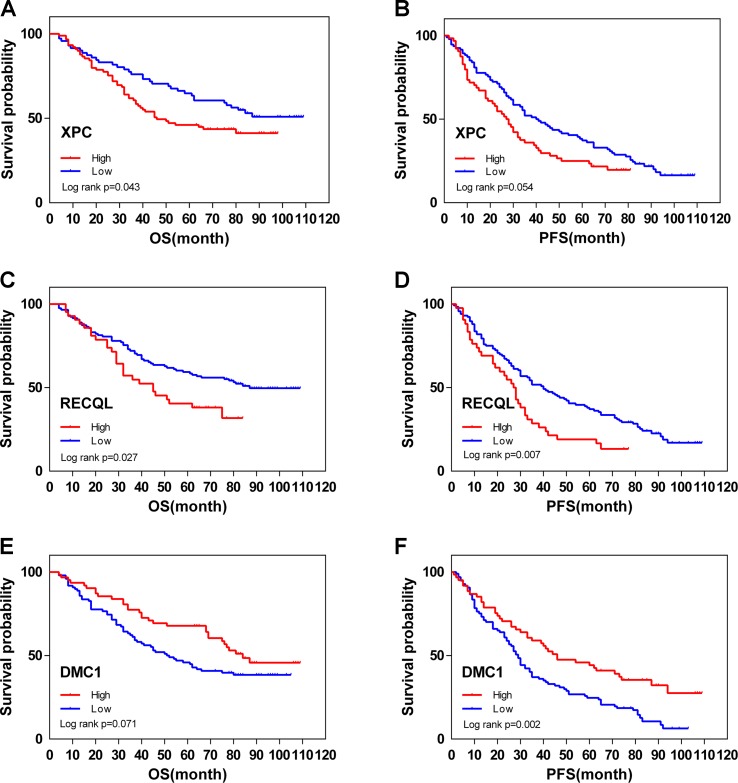
Overall (OS) and disease-free (DFS) survival curves for ovarian cancer (N = 160) according to XPC
(A, B), RECQL
(C, D), and DMC1
(E, F) gene expression status (low or high). Gene expression status was divided according to their median values.